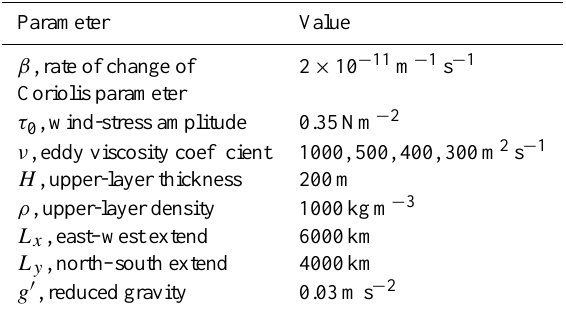
Table 1. Model parameters.